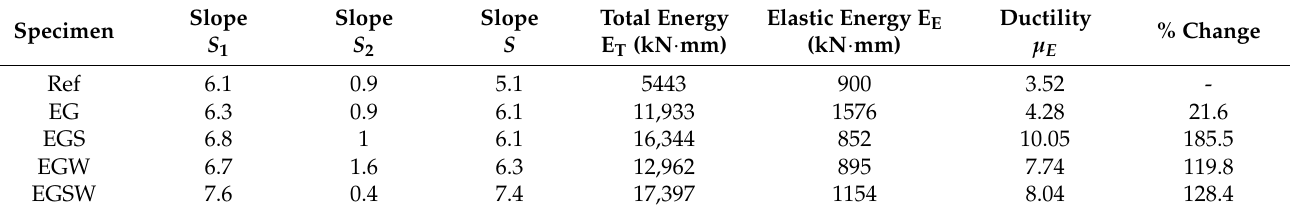
Table 6. The ductility of the tested specimens.